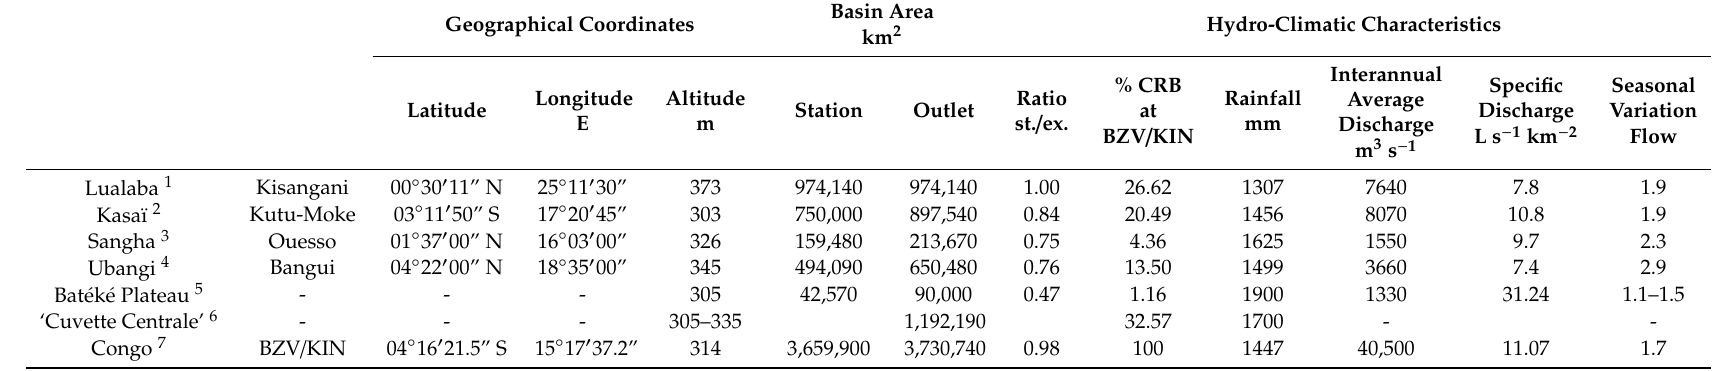
Table 1. The hydro-climatic characteristics in the Congo basin represented at its main hydrological stations [13]. Basin Area Hydro-Climatic Geographical Coordinates